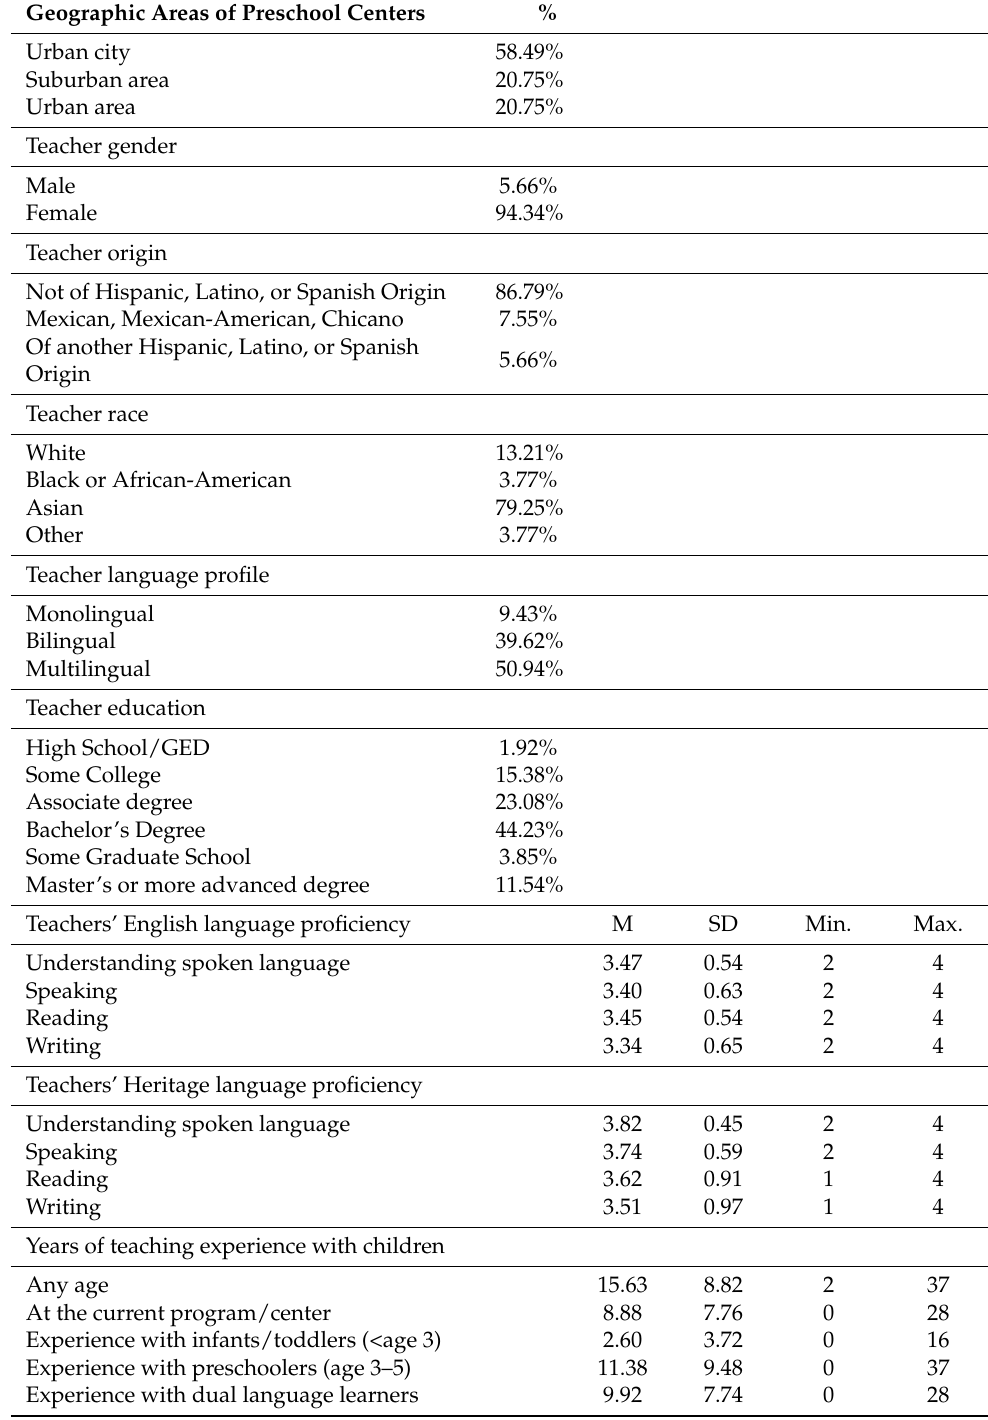
Table 1. Teachers’ demographics, language proficiency, and years of experience ( N =